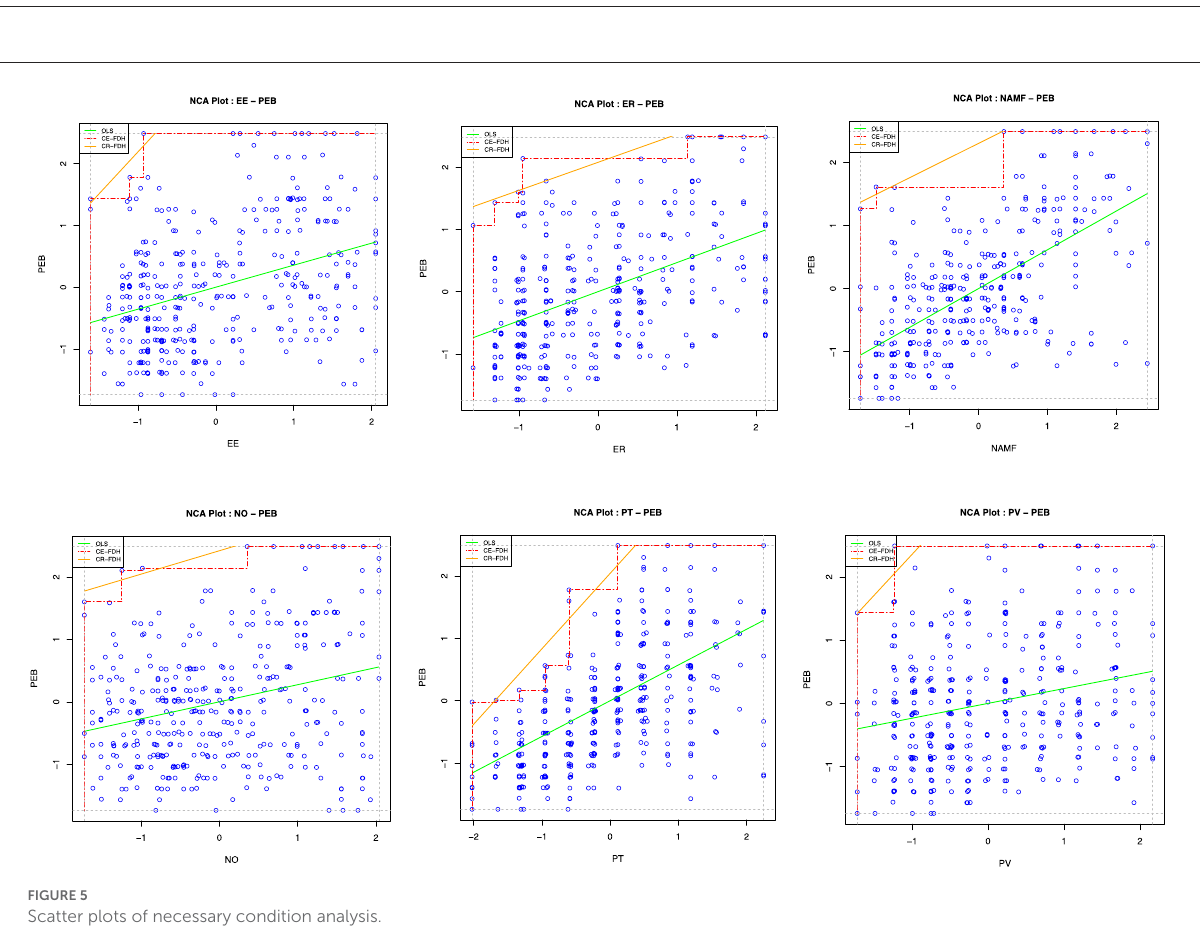
FIGURE5 Scatter plots of necessary condition